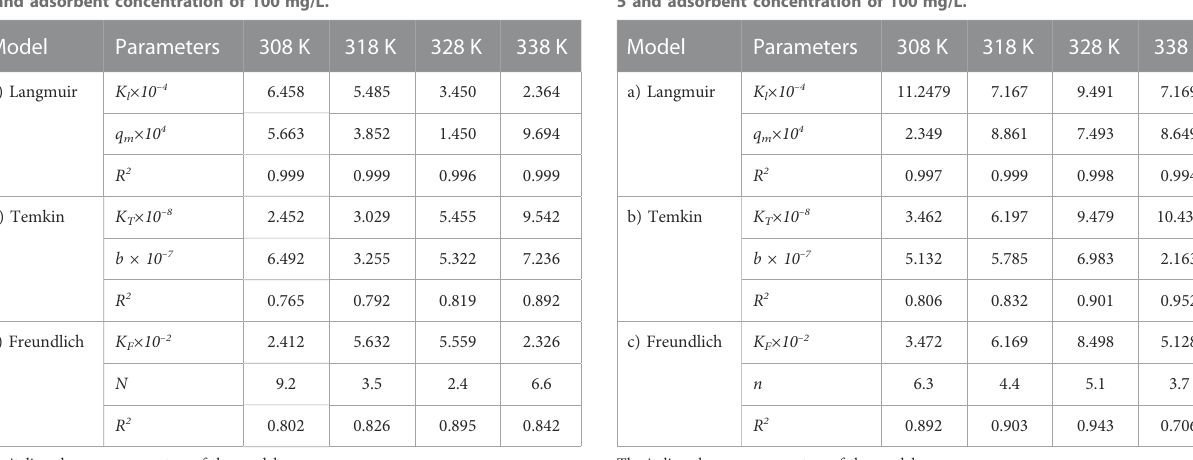
The italic values are parameters of the models.